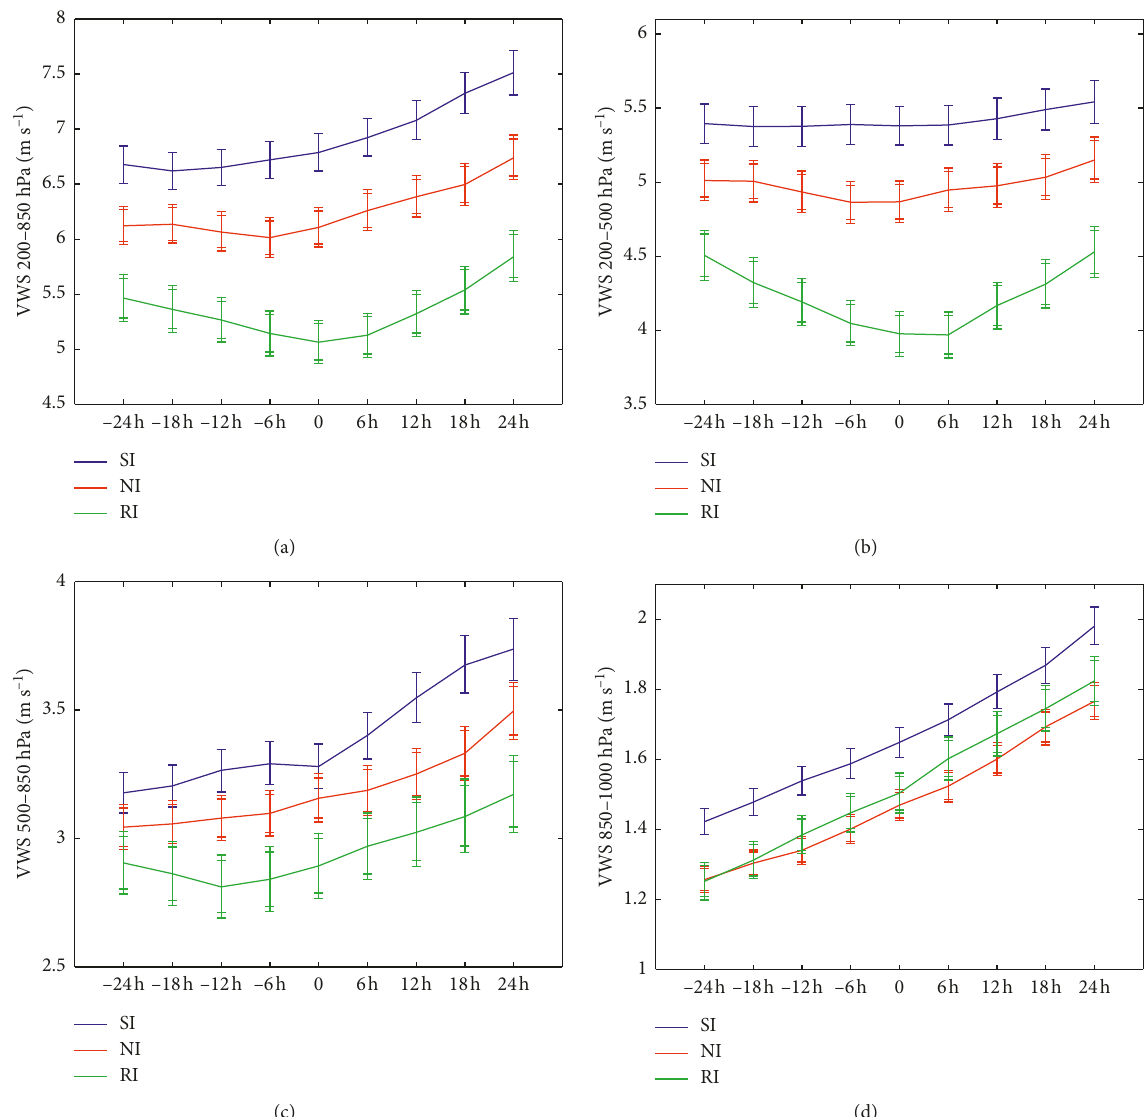
Figure 7: The change in environmental vertical wind shear (VWS, m s − 1 ): (a) deep-layer shear VWS , (b) upper-mid shear VWS , 200 − 850 200 − 500 , (d) low-level shear VWS of RI (green), NI (red), and SI (blue) process. 0 of x -axis is the onset time of (c) mid-low shear VWS 500 − 850 850 − 1000 RI, and − 24h, − 18 h, − 12h, and − 6 h are 24 hours, 18 hours, 12 hours, and 6 hours before intensification. The thick and thin error bars are the 95% and 90% confidence intervals,